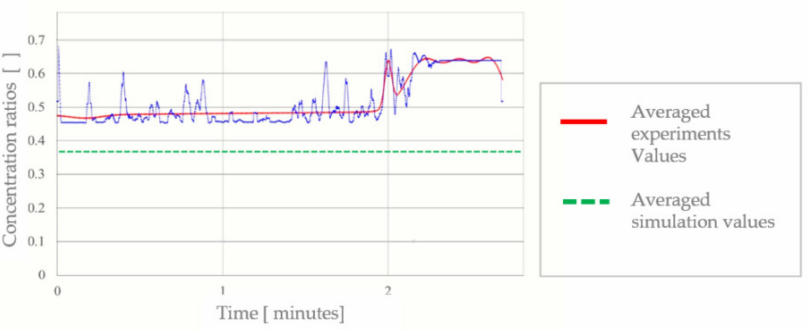
Figure 19. CRF value for experiments and simulations of alumina at flow rates of of 1.9 × 10 − 2